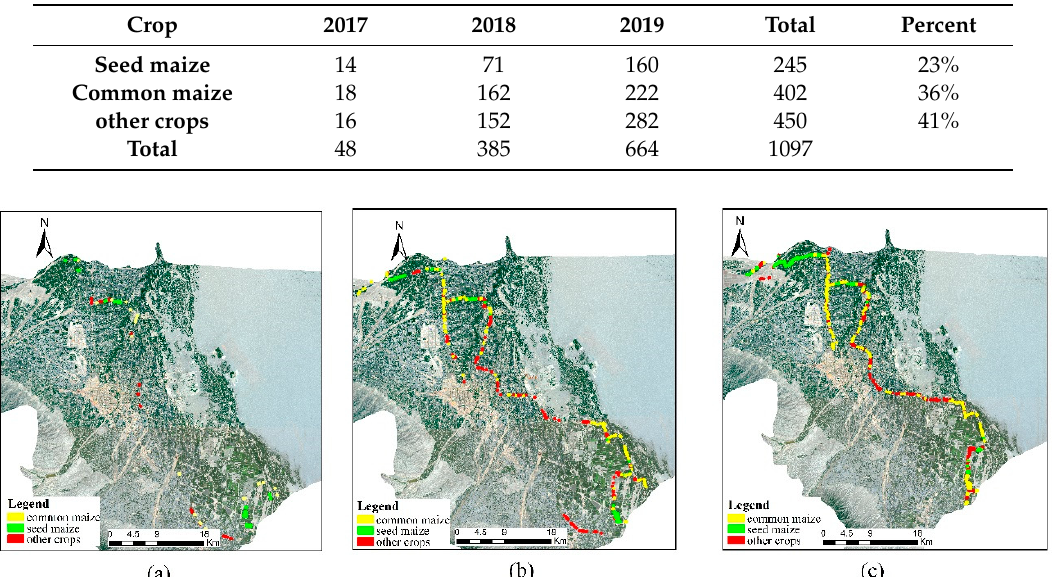
Table 2. Statistics on the field sample data.